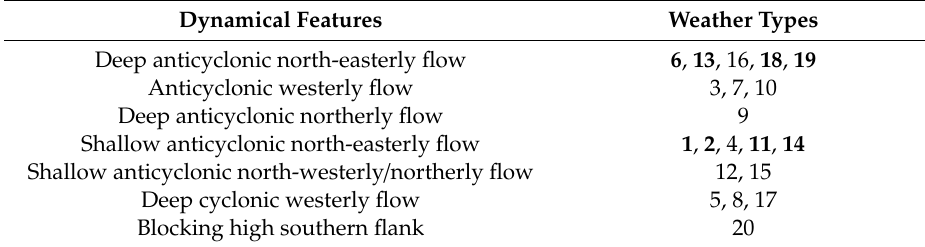
Table 1. Main dynamical large-scale circulation features of the di ff erent weather types, with the following criteria in the Madeira Island area: deep (shallow) vertical structure corresponds to an angle between isobars and 700 hPa geopotential height isolines lower (higher) than 45 ◦ , and large-scale mean flow direction refers to geostrophic wind flow at mean sea level pressure. The WTs responsible for the highest frequency of adverse winds at MIA are in